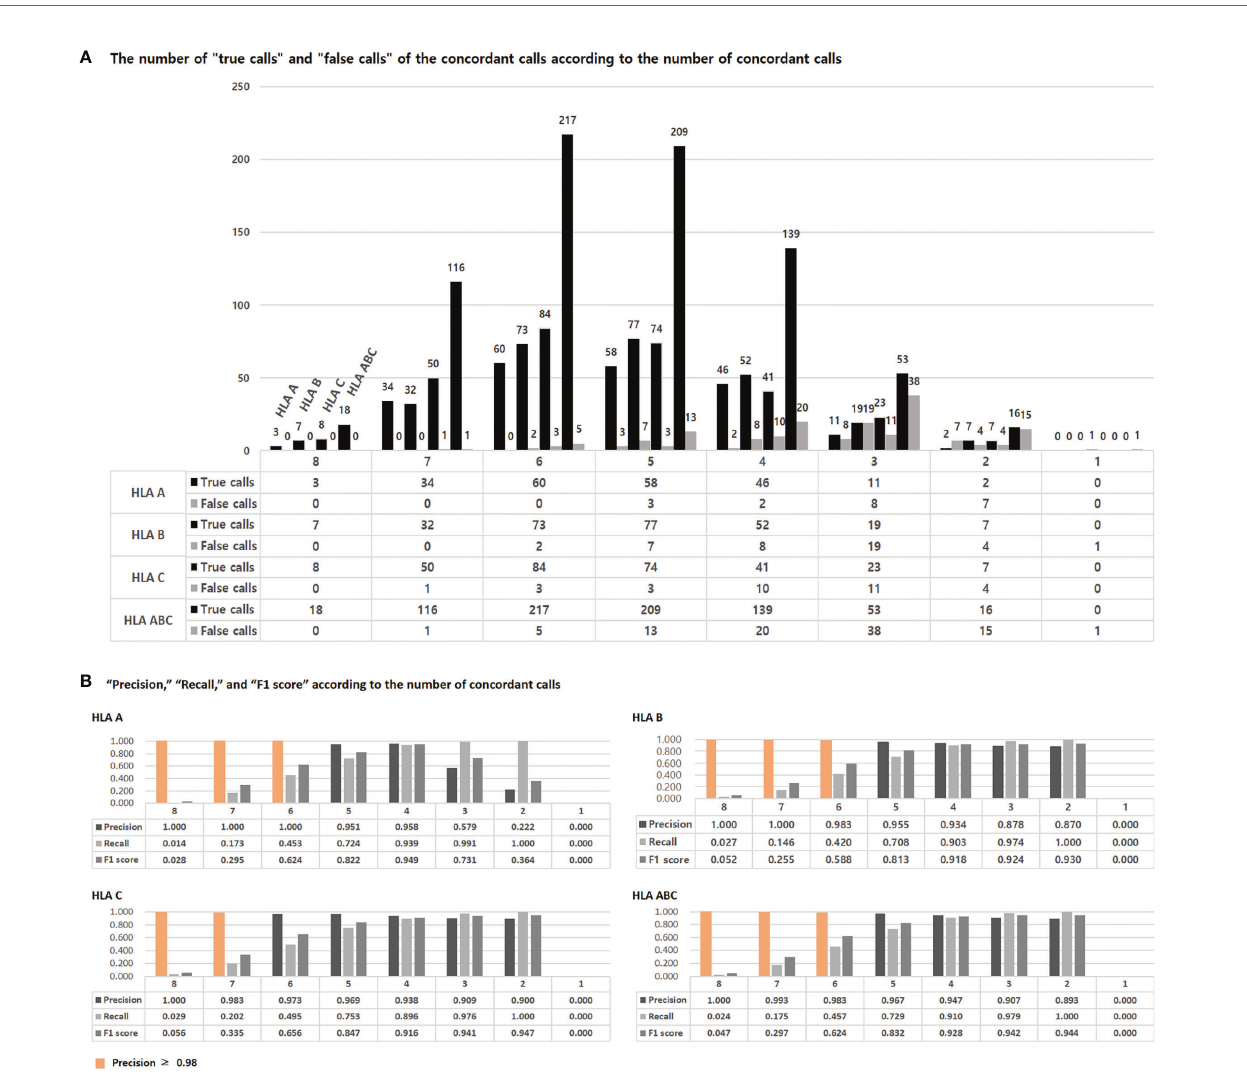
FIGURE 3 | The number of “ true calls ” and “ false call ” of concordant calls according to the number of the concordant calls (A) . The “ true calls ” means that the number of calls that match the HLA type of the 1000 Genome Project data among the concordant calls presented by eight tools. The “ false calls ” means that the number of calls that do not match the HLA type of the 1000 Genome Project data among the concordant calls presented by eight tools. “ Precision ” , “ Recall ” , and “ F1 score ” according to the number of concordant calls (B) . Precision and recall are calculated using “ true calls ” and “ false calls ” , and F1 scores are obtained using these two. The detailed formula is given in the